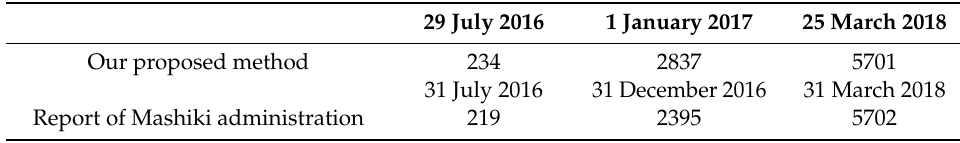
Figure 15. Time series of demolished buildings identified by visual interpretation: ( a ) The whole view of Mashiki town; and ( b ) zoomed-in view of the rectangle area. Table 4. Number of demolished buildings by our proposed method compared to the report of Mashiki